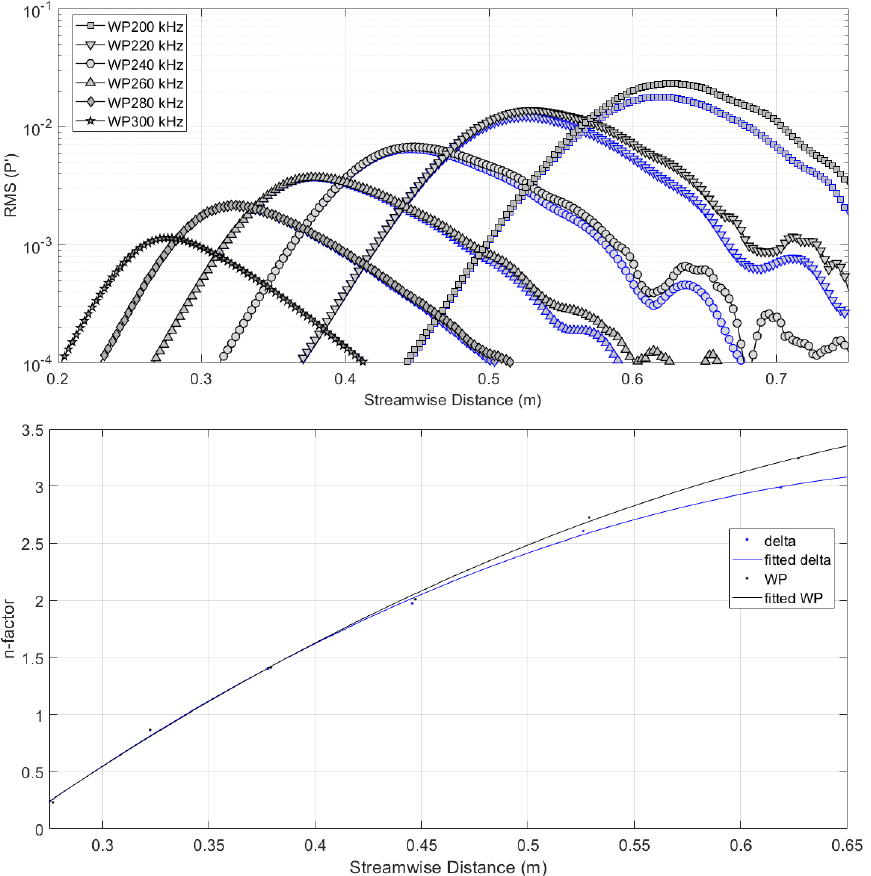
Figure 6. At Notre Dame Tunnel conditions- Upper : NPSE results for a straight cone. Lower : N-factor comparison between traditional discrete (delta-function) and wave packet (WP)